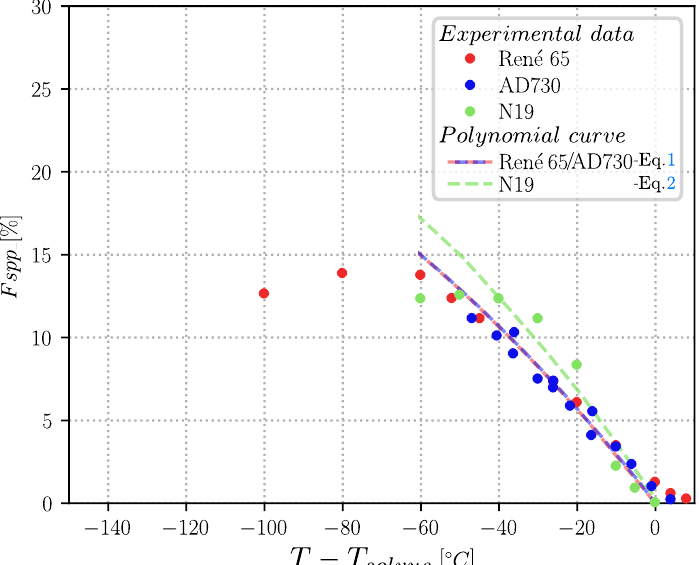
Figure 5. Area fraction of primary γ (cid:48) precipitates after a four-hour isothermal treatment and the respective curves obtained through phenomenological fits established on the shape of the Thermo - Calc curves (described in Equations (1) and